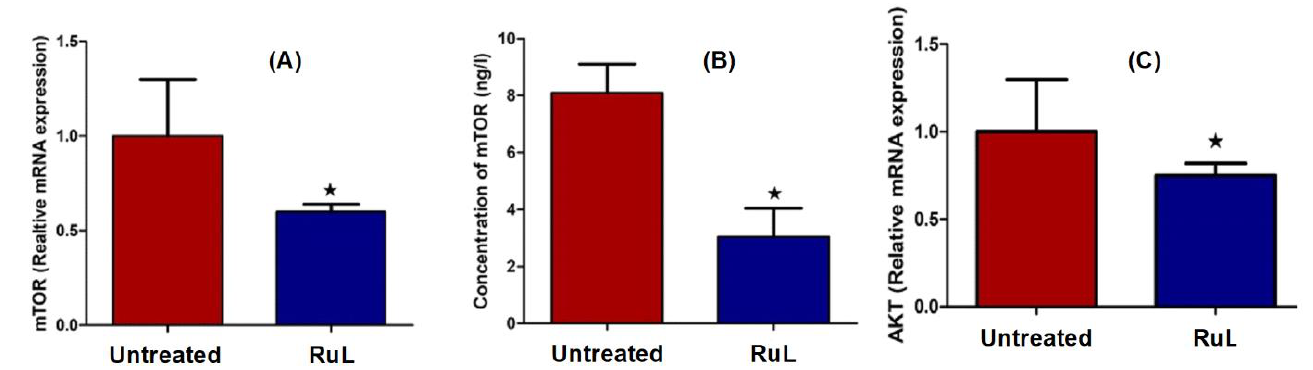
Figure 9. Effect of the RuL complex on AKT and mTOR of HepG2 cells: ( A ) relative mRNA expression and protein level of mTOR, ( B ) effect of different concentrations of mTOR, ( C ) relative mRNA expression of AKT. Data are plotted as mean ± SD of two independent experiments performed in triplicate. Statistical differences were analyzed with a t -test. * Significant at p < 0.05.